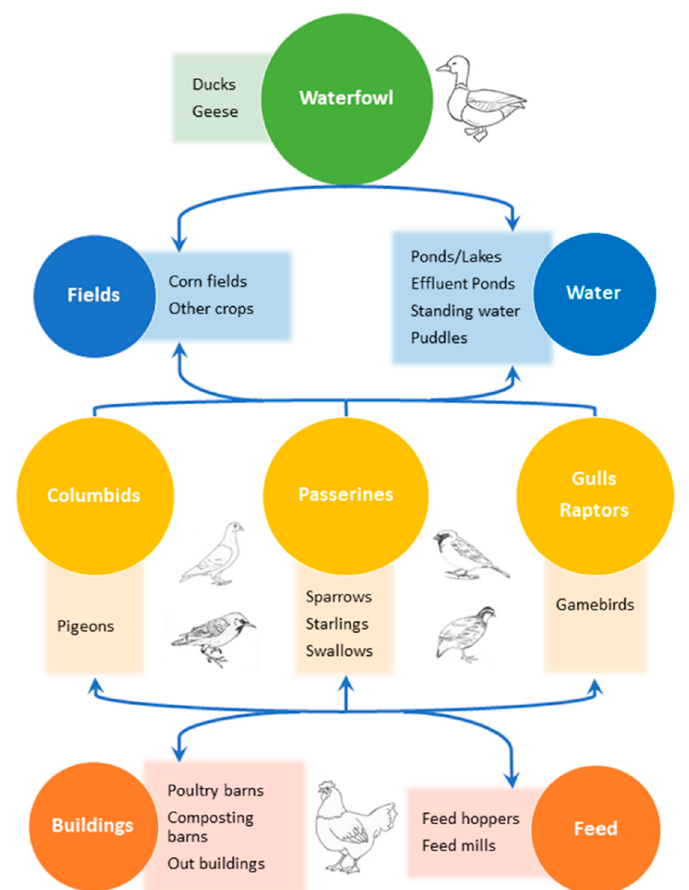
Figure 1. Potential risk paths for transmission, carriage, or transport of avian influenza viruses from reservoir hosts to poultry via bridge species.